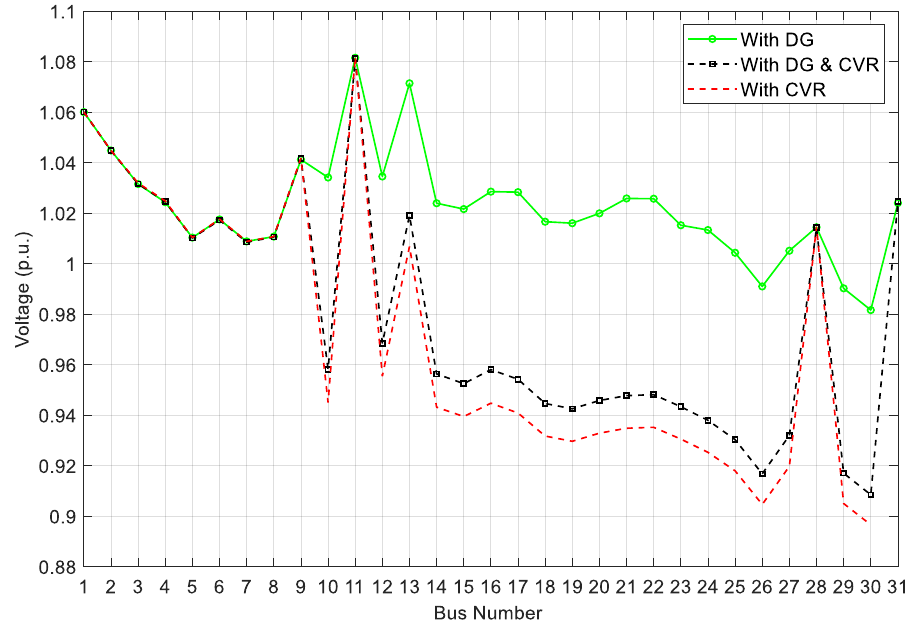
Figure 12. Case V: Voltage profiles with / without CVR in the presence of DG.